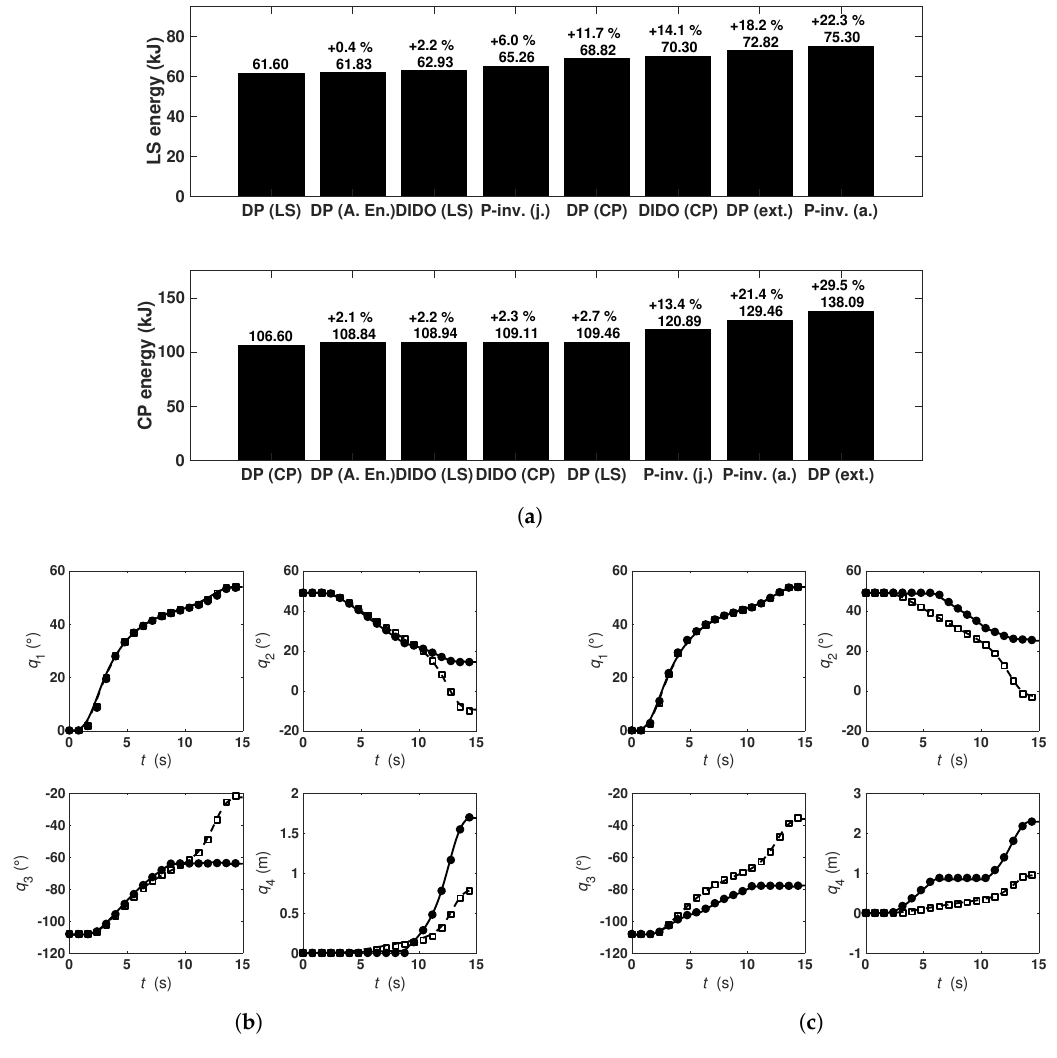
Figure 12. Half-cycle: ( a ) Experimental constant-pressure and load-sensing system energy consumptions (smallest feasible extension cylinder length at the initial configuration); ( b ) load-sensing system: energy-optimal DP (LS) joint trajectories ( ) and controller tracking performance ( P-inv. (a.) joint trajectories ( ) and controller tracking performance ( (cid:151) ); and ( c ) constant-pressure system: energy-optimal DP (CP) joint trajectories ( ) and controller tracking performance ( Sub-optimal P-inv. (j.) joint trajectories ( ) and controller tracking performance ( (cid:151)